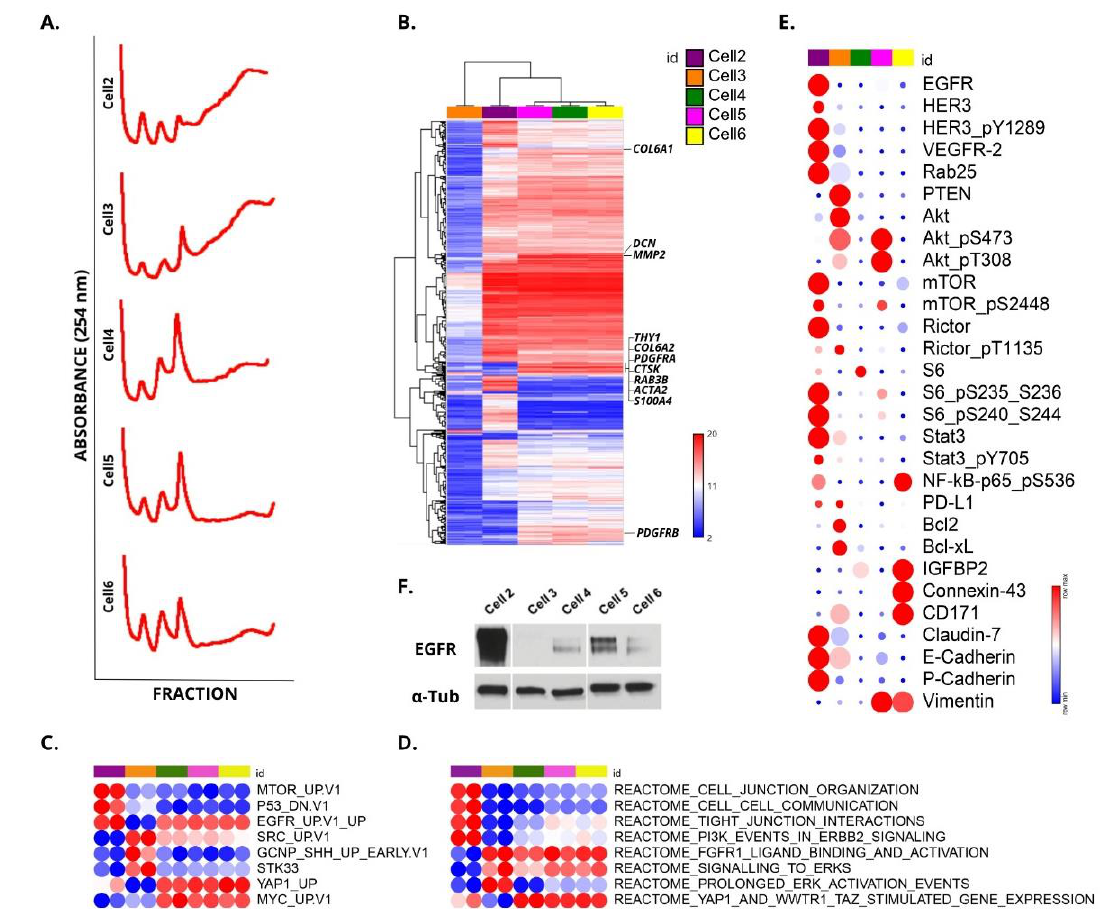
Figure 3. Molecular profile of penile cancer (PeCa)-derived cells. ( A ) Polysomal profiling of cells 2, 3, 4, 5, and 6. Polyribosome (polysome) fractionation was performed using a sucrose density gradient (5–50%). ( B ) Translatomic profiling (Clariom™ D Assay platform, Thermo Fisher Scientific,